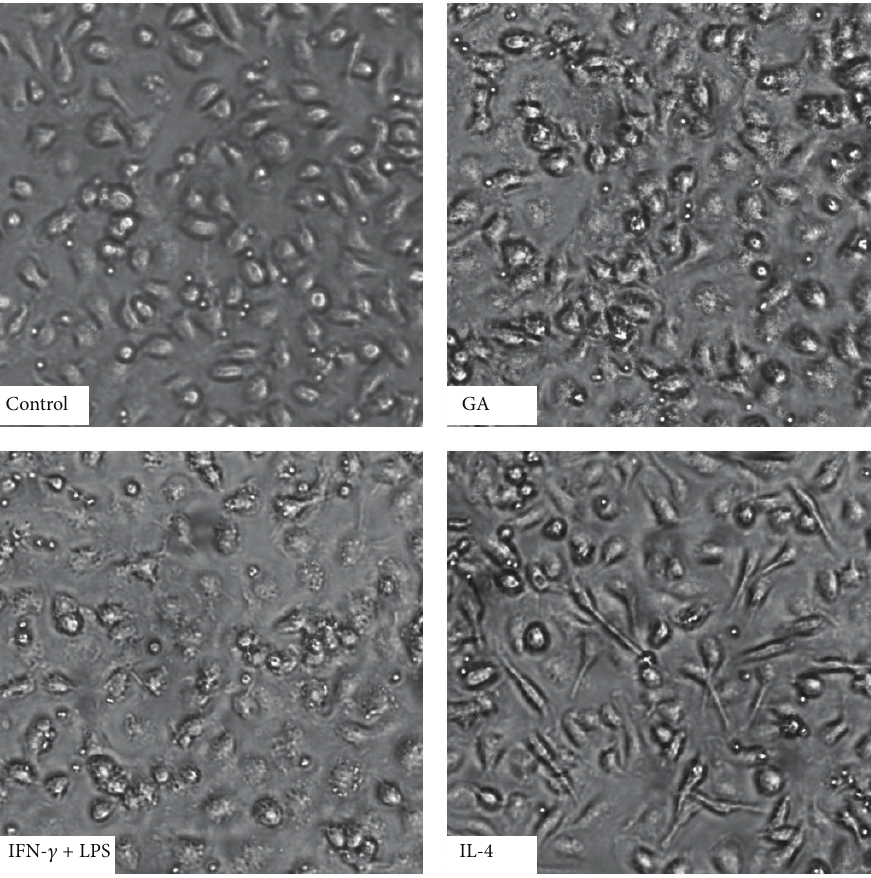
Figure 3: Effect of GA on morphological characteristics of BMDMs. BMDMs were treated with PBS, GA (100 𝜇 g/mL), IFN- 𝛾 (15ng/mL) + LPS (15ng/mL), and IL-4 (20ng/mL) for 48h. The cell images were obtained under a light microscope ( ×